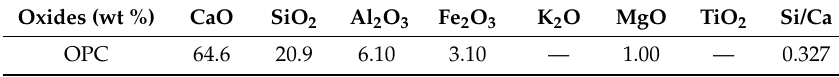
Table 1. Chemical composition of cement (expressed as oxides).